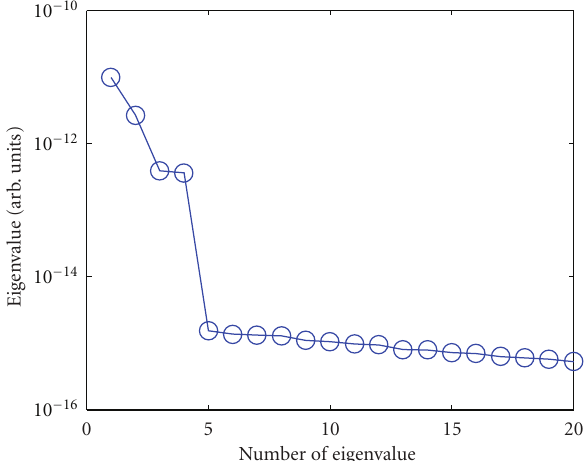
Figure 3: A logarithmic plot of the first 20 PCA